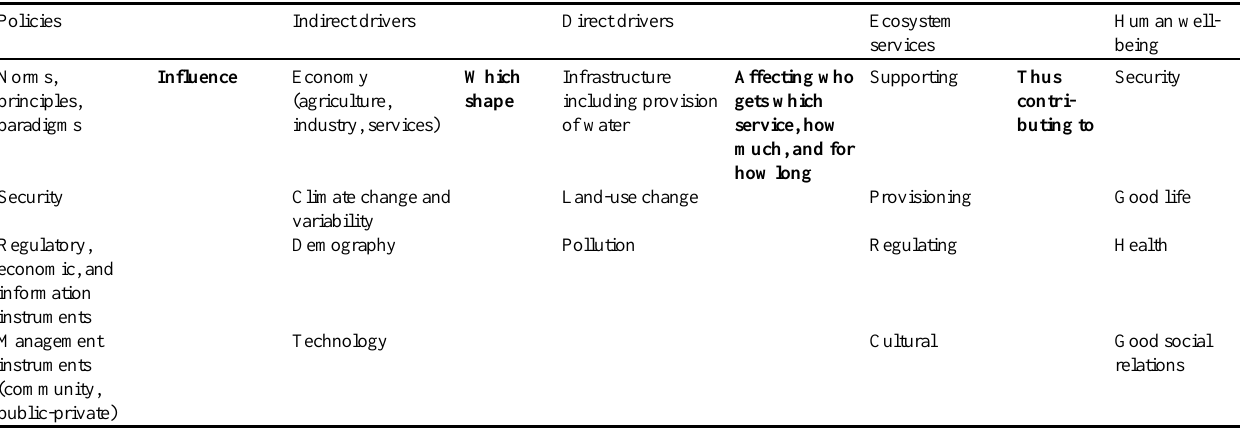
Table 1 . Policies and drivers affecting the ecosystem services of